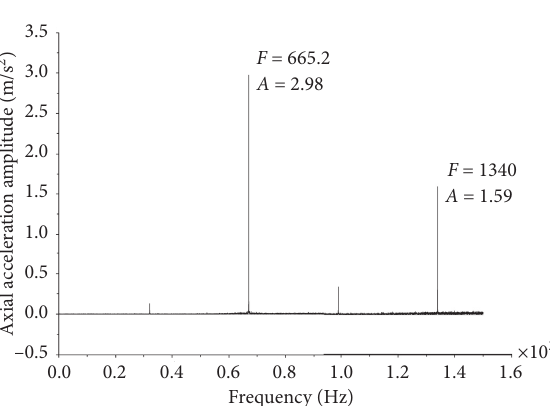
Figure 10: Axial acceleration of the optimal model.